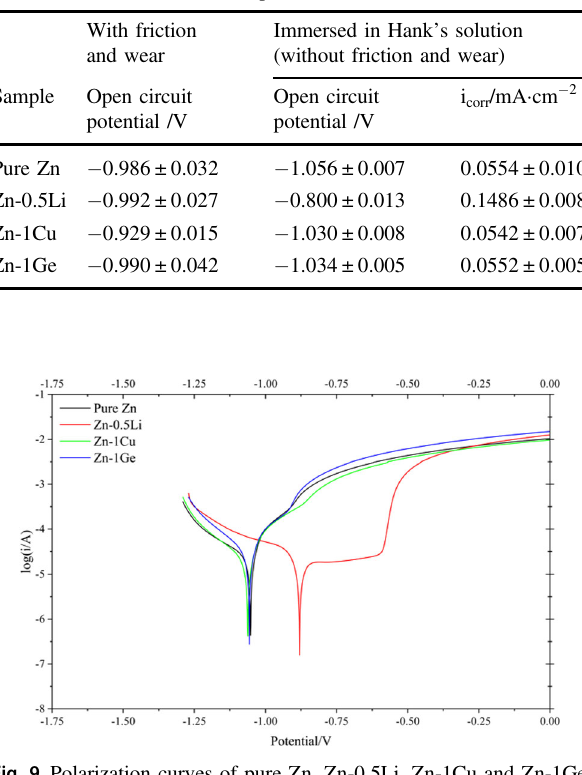
Fig. 9 Polarization curves of pure Zn, Zn-0.5Li, Zn-1Cu and Zn-1Ge immersed in Hank ’ s